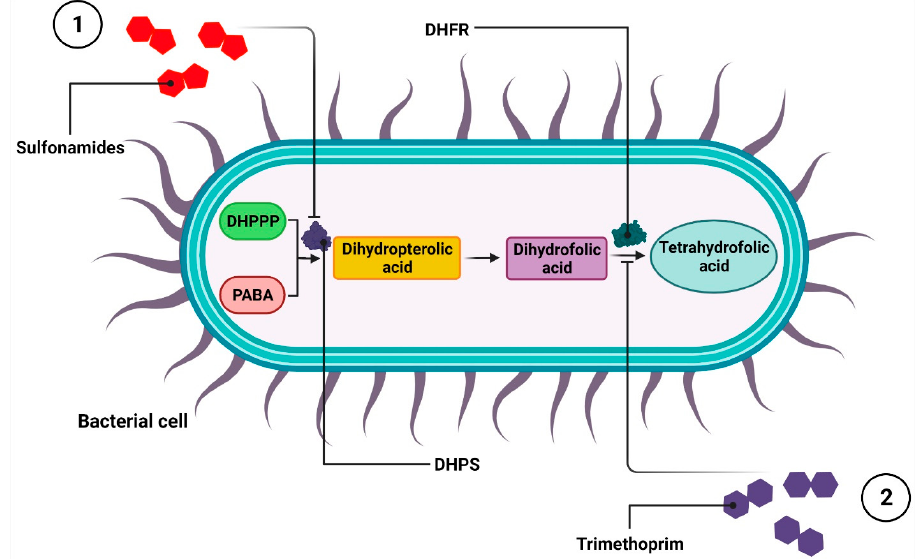
Figure 6. Mechanism of action of antibiotics targeting folic acid synthesis: ( 1 ) sulfonamides and ( 2 ) trimethoprim. Dihydropteroate synthase (DHPS), a critical enzyme in the formation of dihydrofolate, is inhibited by sulfamethoxazole, and dihydrofolate reductase (DHFR) is inhibited by trimethoprim. Figure created with Biorender.com.